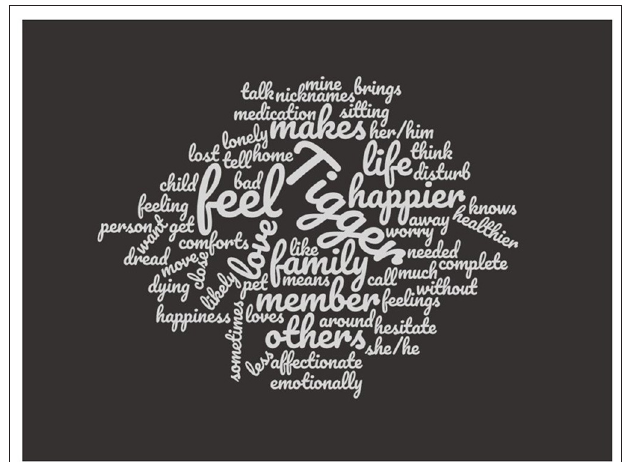
FIGURE 1 | Word cloud of words in items on the Family Bondedness Scale. Larger font words are those appearing more frequently in Family Bondedness Scale items, and vice versa. It was assumed in the creation of this cloud that the name of the pet was “Tigger,” so this word is largest in the word